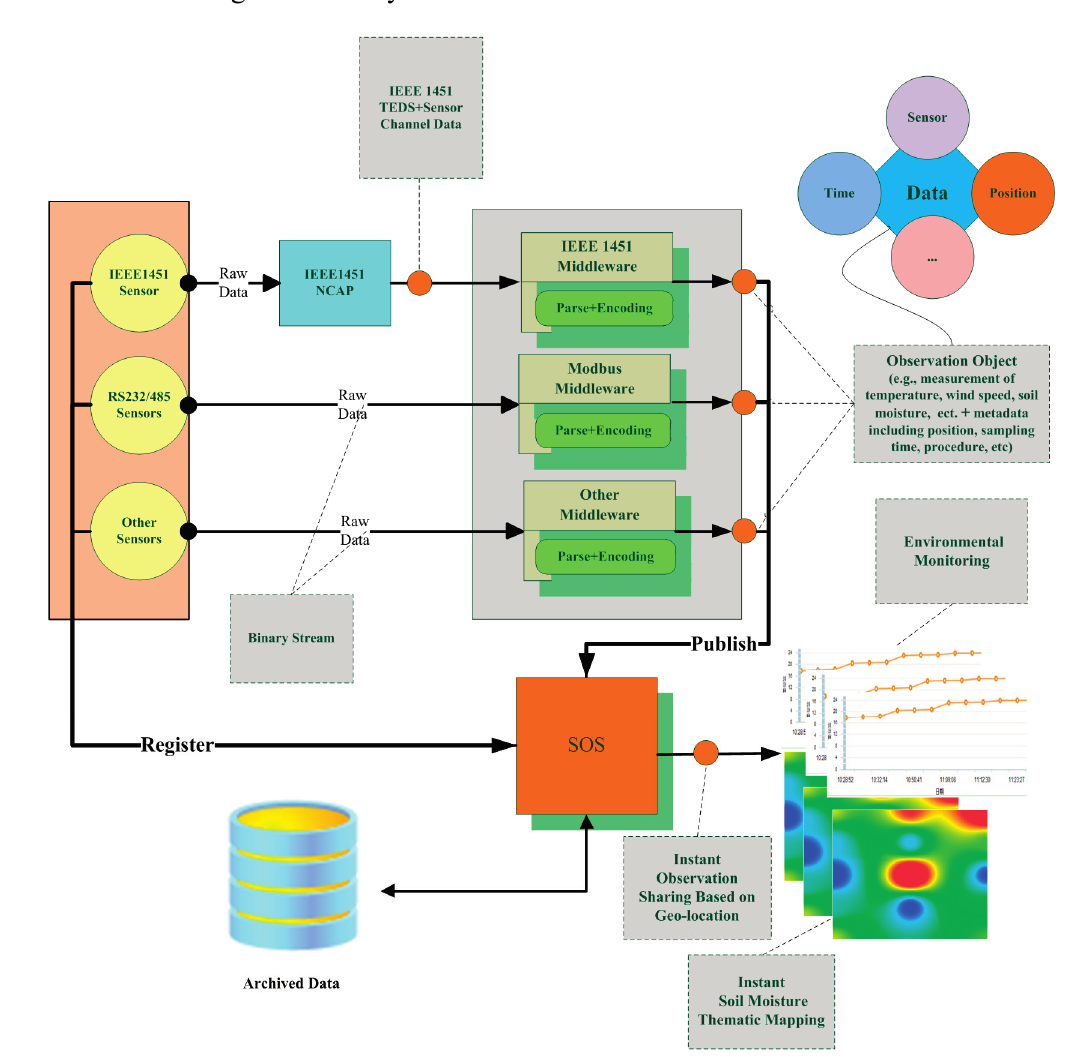
Figure 2. Location-based instant sensing of diverse in-situ